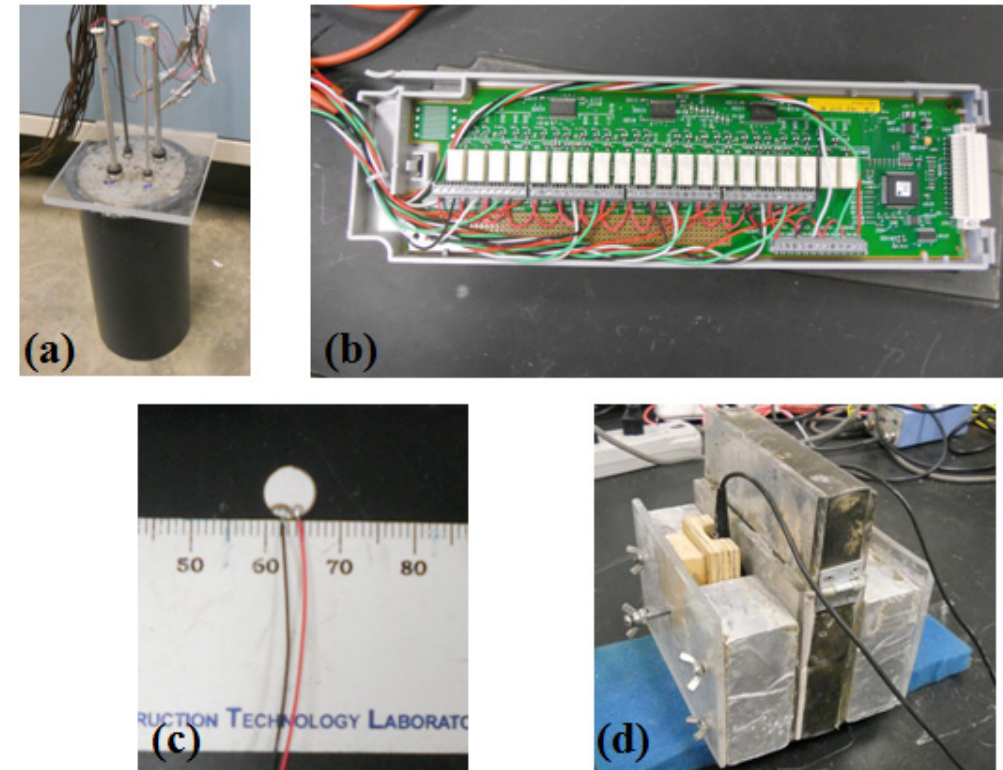
Figure 1. Ultrasonic Test setups: ( a ) guided wave testing; ( b ) 34903A switching card; ( c ) 7 mm diameter piezo disc and ( d ) shear wave measurement.